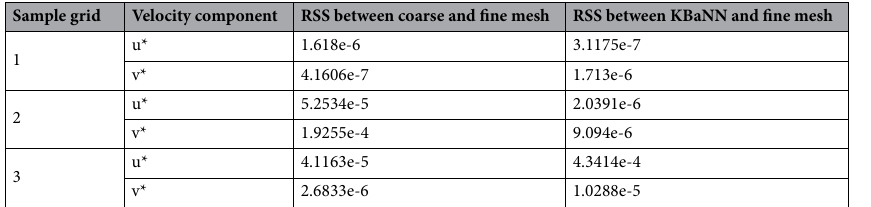
Table 2. The RSS between the KBaNN predictions and the fine mesh for each of the sample grids pictured in Fig. 8a. For comparison the RSS between the coarse and fine mesh is included. As can be seen, the KBaNN improves significantly on the fine mesh prediction, provided the sample grid is within the training